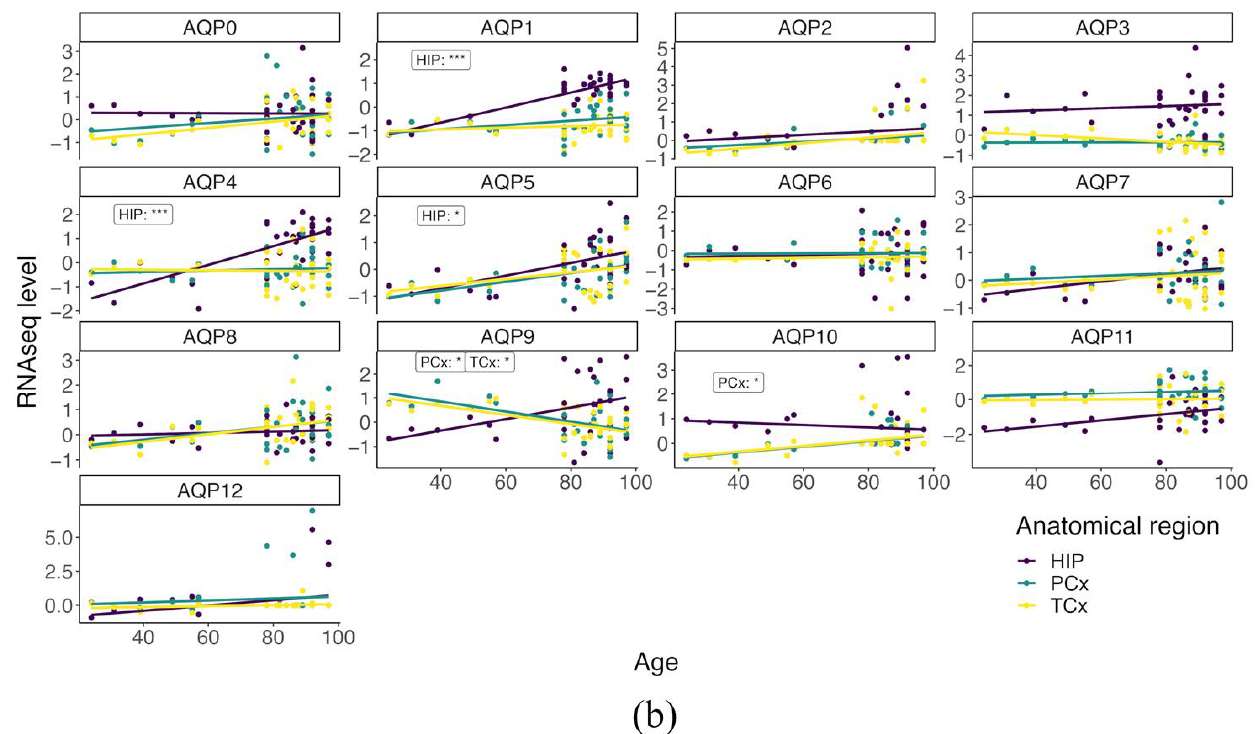
Figure 1. AQP expression profiles show region-specific changes with age in healthy human brains. ( a ) Mixed-effect linear plot testing the relationship between all AQP RNAseq levels and age in the HIP (purple), PCx (green) and TCx (yellow) brain regions. Each point represents the RNAseq level determined for a given gene in a single subject for the selected brain region: HIP (purple), PCx (green) and TCx (yellow). t -values represent the test statistic associated with the comparison of the two means using two-sample t -tests, with positive values indicating a larger average RNAseq. ( b ) Linear regression plots of individual AQP channels and RNAseq levels as a function of age separated by anatomical areas with a significance change in trends are shown, respectively, as *** for p < 0.001 and * for p < 0.05. The p values for regressions that had significant non-zero slopes are listed as inset text boxes within each figure panel.